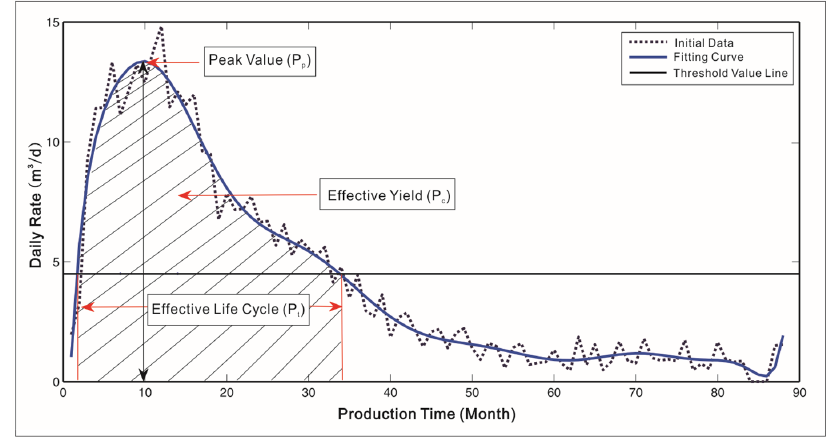
Figure 6. Three parameters used to characterize oil production performance of CHOPS wells (taken from [3]).